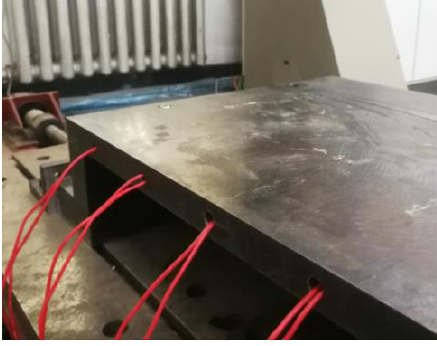
Figure 12. Mold heating diagram.